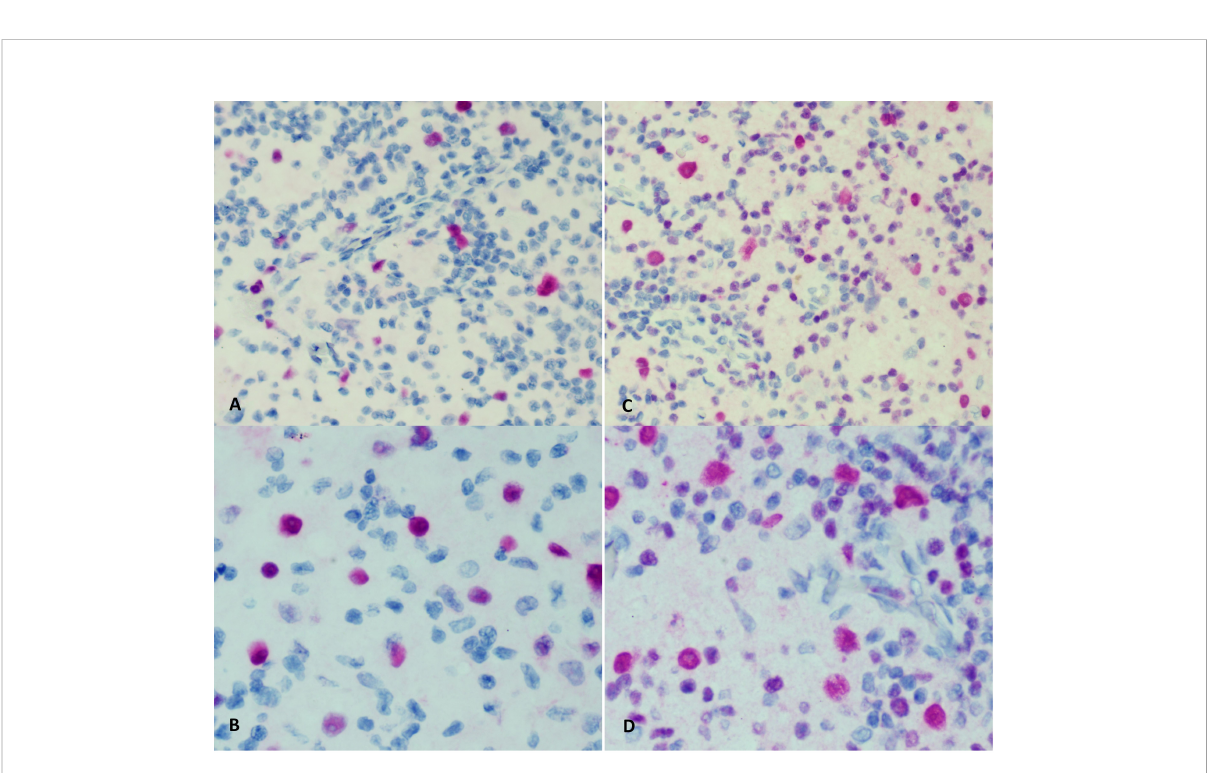
FIGURE 3 Immunohistochemical staining for cyclin D1 (A, B) and OCT2 (C, D)